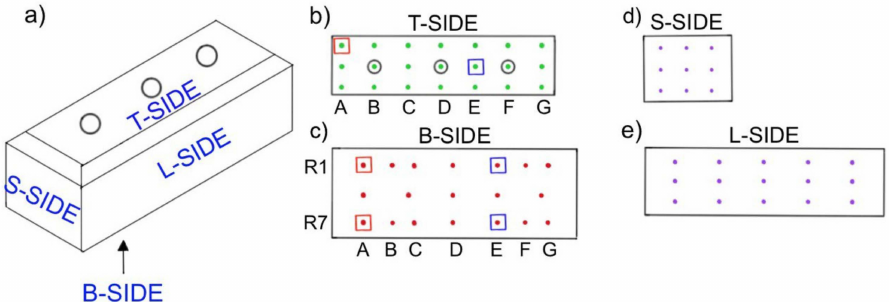
Figure 3. Sensor positioning for the 3D toy examples. ( a ) Identification of the anode sides, ( b ) excita- tion positions (emitter) in S1 configuration (green dots), ( c ) receiver positions in S1 configuration (red dots), ( d ) excitation positions on the short side in S2 configuration, and ( e ) excitation positions on the long side in S2 configuration. Red and blue squares illustrate how receivers R1 and R7 move with the emitter along the length of the anode in S1